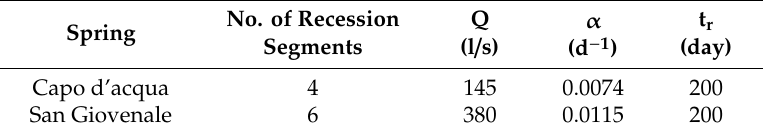
Table 5. Recession curve characteristics of aquifer springs with unimodal behavior. No. of Recession Spring